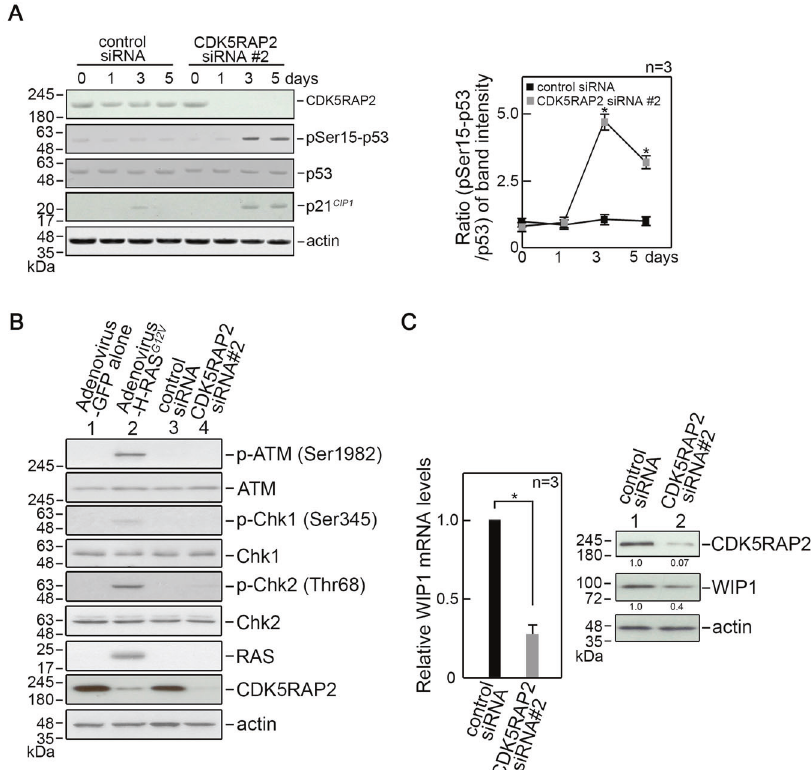
Fig. 3 CDK5RAP2 loss triggers cellular senescence through downregulation of WIP1-mediated p53 activation. A Lysates of cells transfected with CDK5RAP2 siRNA #2 for 1, 3, and 5 days were analyzed by SDS-PAGE and immunoblotting for CDK5RAP2, phosphoSer15-p53 (pSer15-p53), p53, p21 CIP1 , and actin ( A , left panel). Actin blot was used as a loading control. Representative blots are from one of three independent experiments ( n = 3) showing similar results. Ratios of levels of phosphoSer15-p53 (pSer15-p53) vs. total p53 and standard deviation for the 3 independent sets of experiments ( A , right panel) were calculated as described for CDK5RAP2 vs actin in Fig. 1, with values from cells transfected with control siRNA at day 0 normalized to 1.0. * p < 0.005. B Lysates of cells infected with adenovirus carrying H-RAS G12V or transfected with CDK5RAP2 siRNA #2 for 3 days were analyzed by SDS-PAGE and immunoblotting for CDK5RAP2, phosphoSer1982-ATM (pSer1982-ATM), ATM, phosphoSer345-Chk1 (pSer345-Chk1), Chk1, phosphoThr68-Chk2 (pThr68-Chk2), Chk2, H-RAS, and Actin. Actin blot was used as a loading control. C CDK5RAP2 loss represses WIP1 mRNA and protein expression. Levels of WIP1 mRNA in cells transfected with CDK5RAP2 siRNA #2 were determined by qRT-PCR using isolated total RNA as template. GAPDH was used for normalization. Relative levels of WIP1 mRNA (left panel) were calculated using the 2 − ΔΔ CT method. Relative levels from cells transfected with control siRNA were normalized to 1.0. Data represent means ± SD of calculated ratios from three independent experiments ( n = 3). * p = 0.002. WIP1 protein expression was analyzed by immunoblotting. Actin blot was used as a loading control. Representative blots from one of three independent experiments ( n = 3) showing similar results are shown. Ratios of levels of WIP1 vs actin for the 3 independent sets of experiments were calculated as described for CDK5RAP2 vs actin in Fig. 1, with values from cells transfected with control siRNA normalized to 1.0. * p <